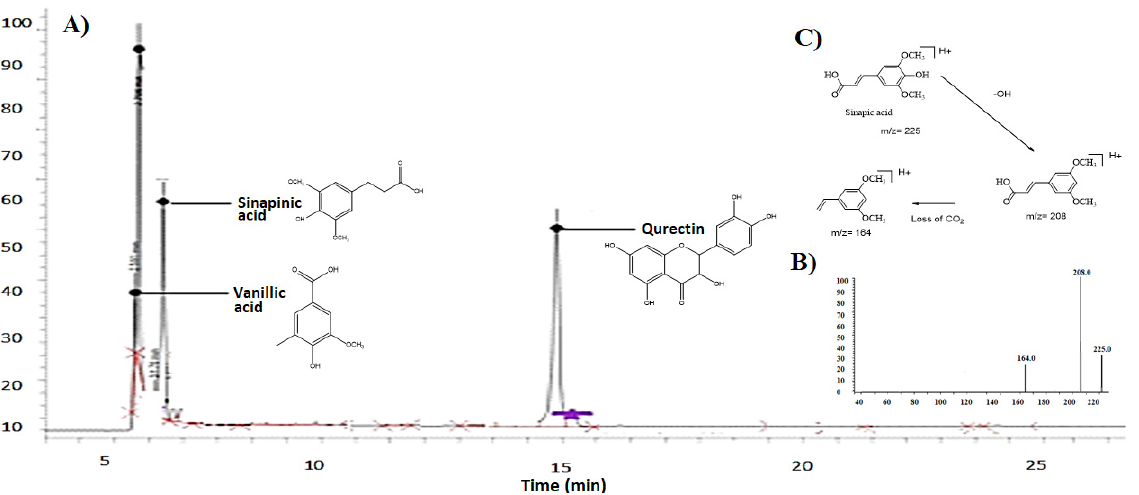
Figure 2. ( A ) HPLC chromatogram of P. stewartii Hf. plant extract, ( B ) mass spectrogram of sinapinic acid and ( C ) fragmentation pattern of sinapinic acid. Table 2. Chemical compounds in P. stewatrii Hf. extracts determine by LC-ESI-MS. Major LC/MS m / z (Intensity) Molecular for-Molar Mass Mula Name of Identified Compound